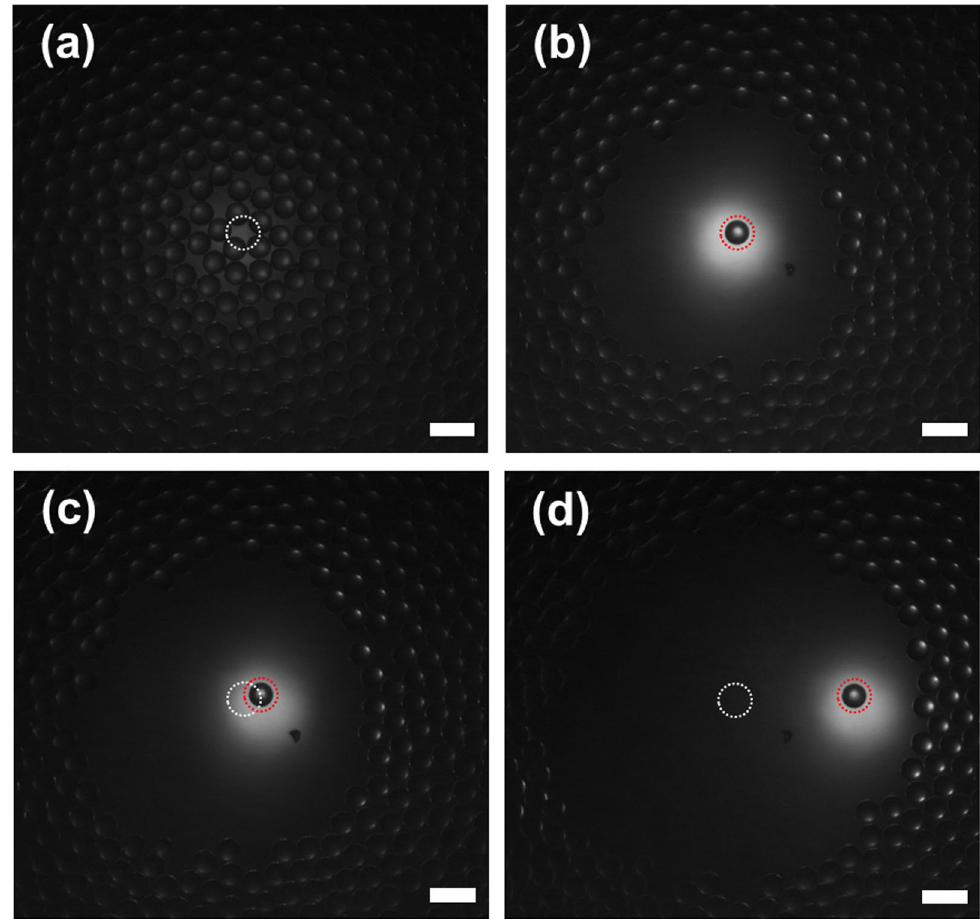
Figure 2. Images of polystyrene microspheres acquired by inverted fluorescence microscope ( a ) before and ( b ) after transmitting monocycle pulses with a length of 6.7 ns and a magnitude of 10 V at a PRF of 167 kHz to tightly focused high-frequency ultrasound transducer. As the transducer was moved to the right while delivering ultrasound microbeams at a PRF of 167 kHz, the captured microsphere was also moved in the same direction ( c ) and ( d ). White and red dashed circles indicate the initial and moved locations of the transducer, respectively. Scale bars in the images indicate 100 µ